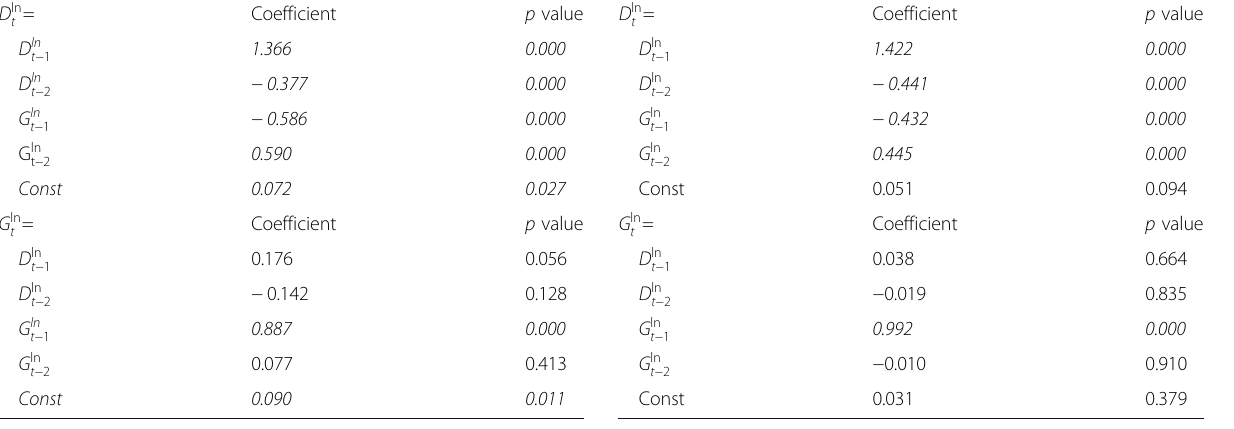
Table 5 Coefficients ’ estimations of a VAR (2) model between the D ln and G ln for all phases. Top: model for D ln t t model for G ln . Italics: significant results with 5% t